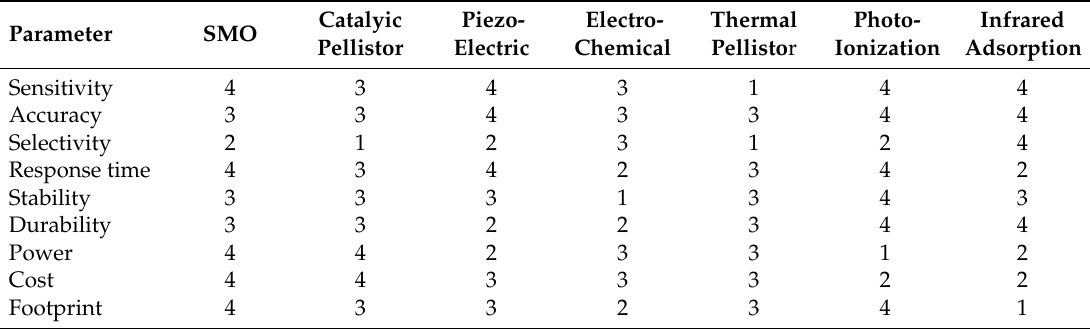
Table 1. Summary of available gas sensing technologies and their evaluation according to several parameters, including sensitivity, accuracy, selectivity, response time, stability, durability, power, cost, and footprint. The number ratings correspond to: 4 = Excellent, 3 = Good, 2 = Fair, 1 =